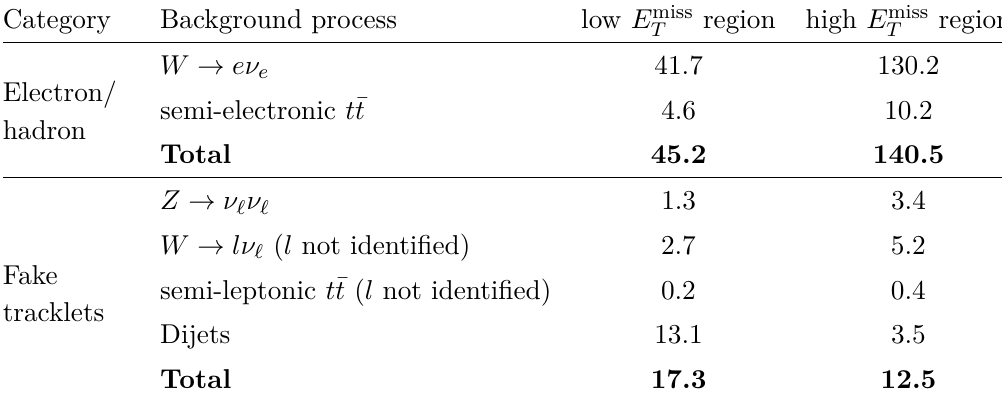
Table 3 . Number of background events normalized to a luminosity of 36.1 fb − 1 , broken down by constituent SM process and phase space region. The total number of events for each background category and phase space region is identical to that in the ATLAS analysis by